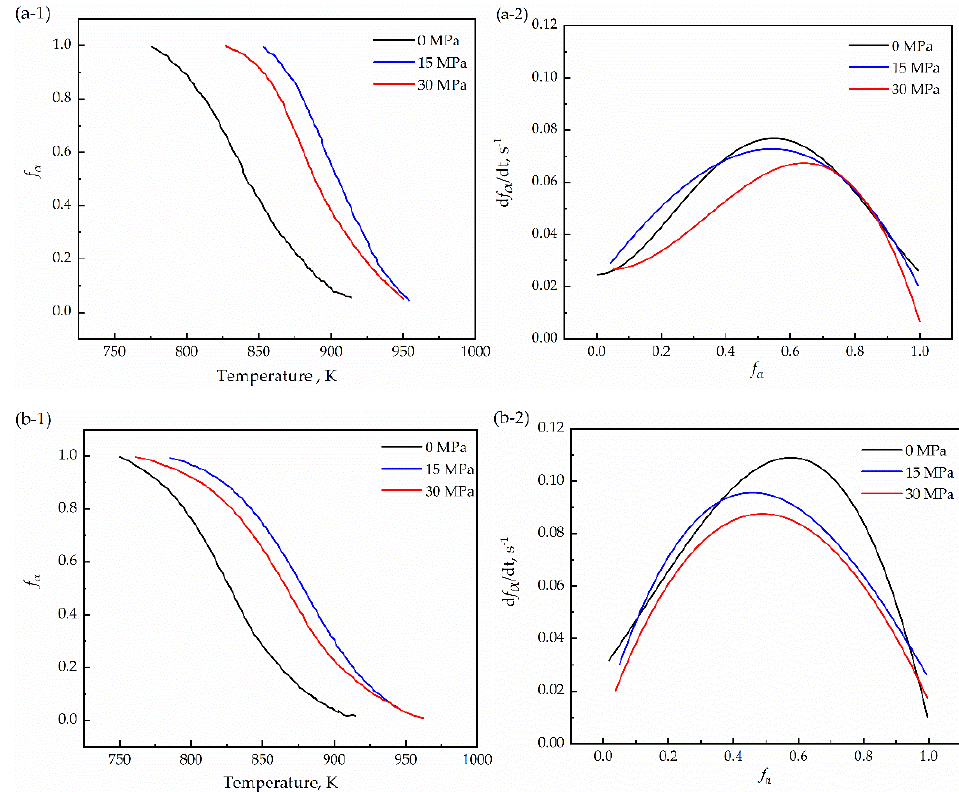
Figure 7. Ferrite volume fraction via lever principle ( a-1 , b-1 ), and ferrite-formation rate ( a-2 , b-2 ) of the sample as a function of temperature under cooling rate of 25 K/min, 50 K/min, respectively.